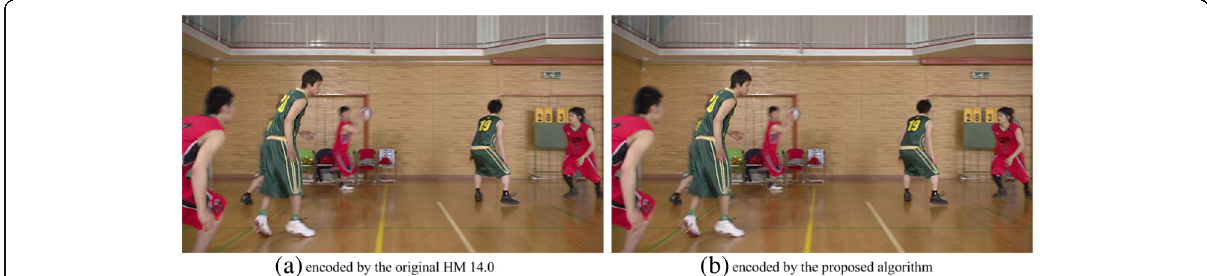
Fig. 10 Comparison of the subjective quality of the 42nd frame in test sequence “ BasketballDrive ” a Encoded by the original HM 14.0. b Encoded by the proposed algorithm